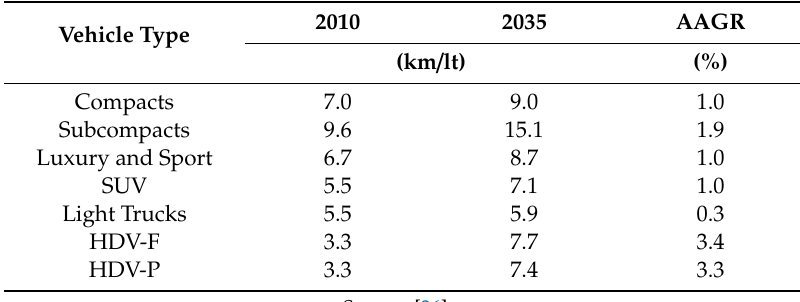
Table 4. Fuel economy evolution by vehicle type.